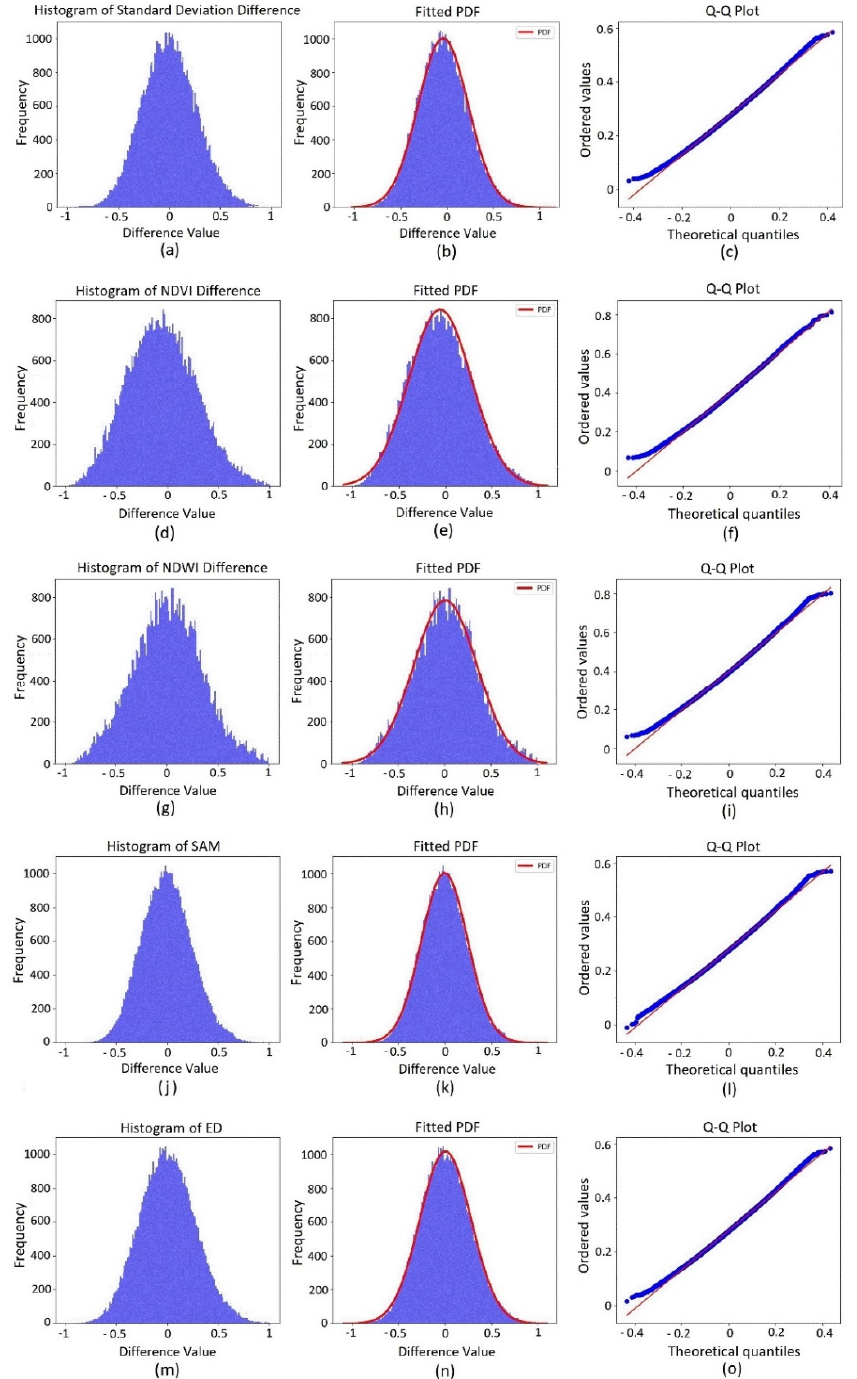
Figure 6. Normality test for the change image of the target year of 2021. ( a , d , g , j , m ) The histogram of the change images. ( b , e , h , k , n ) The fitted PDF. ( c , f , i , l , o ) The Q-Q plot of the change images.